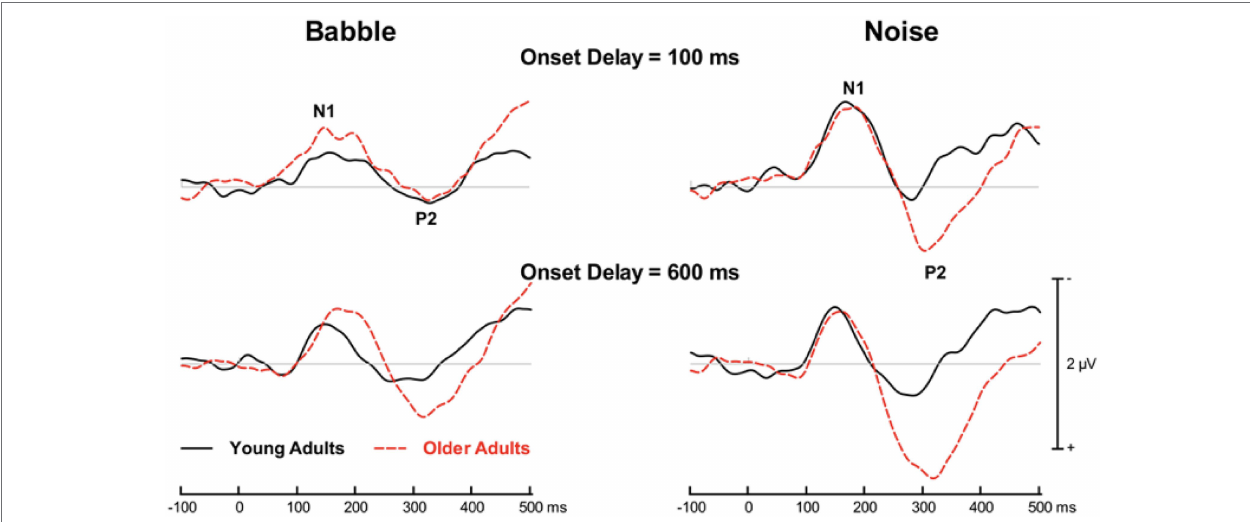
FIGURE 3 | Group mean event-related potentials time-locked on word onset. Traces are shown when the target word was preceded by 100 ms of masker (top row) or 600 ms of masker (bottom row). The electrophysiological responses to the target word embedded in babble are shown on the left whereas those obtained when the word was embedded in speech spectrum noise (i.e., noise) are shown on the